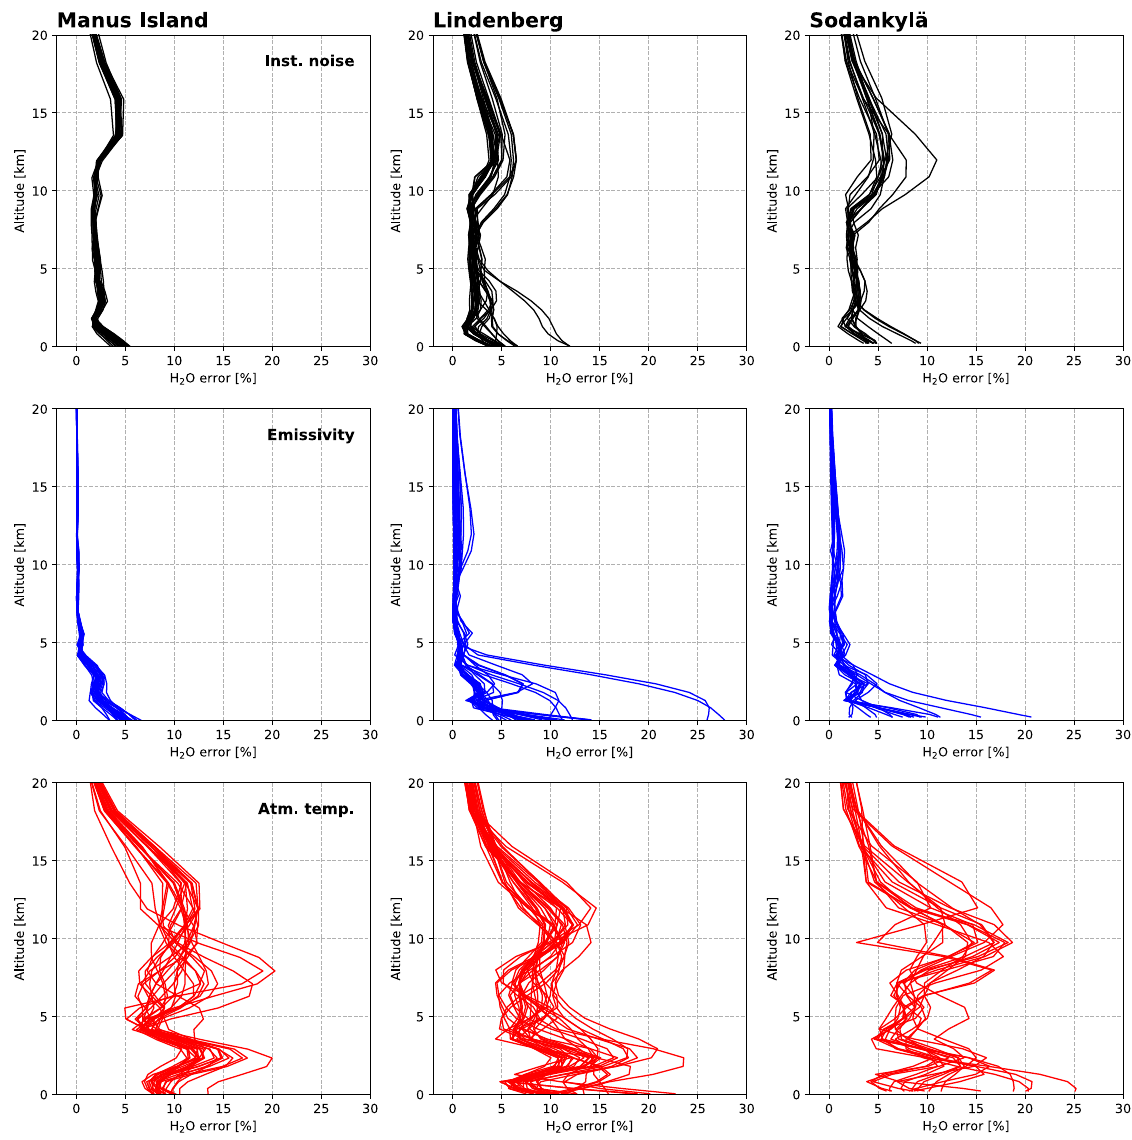
Figure 7. H 2 O error profiles derived from the random uncertainty sources: instrument noise, emissivity, and atmospheric temperatures. The square root values of the diagonal of the matrices S ˆ x, noise (for instrument noise) and S ˆ x, b (for emissivity and atmospheric temperatures) are shown according to Eqs. (9) and (8), respectively. The data are depicted for all members of the MI, LI08, and SK07